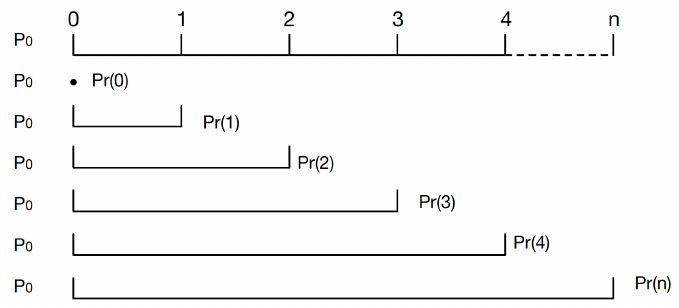
Figure 2. Schematic diagram of multi-point